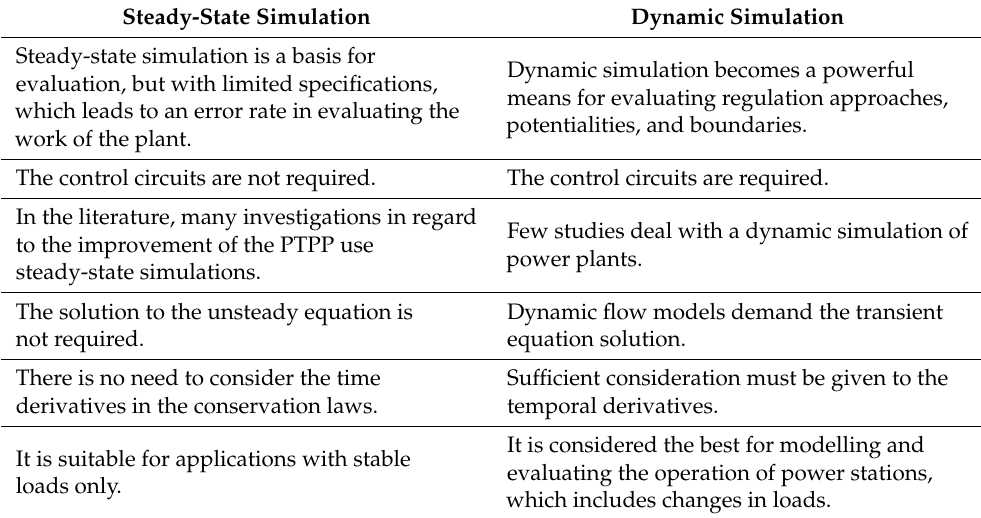
Table 3. Comparison between dynamic and steady-state simulation